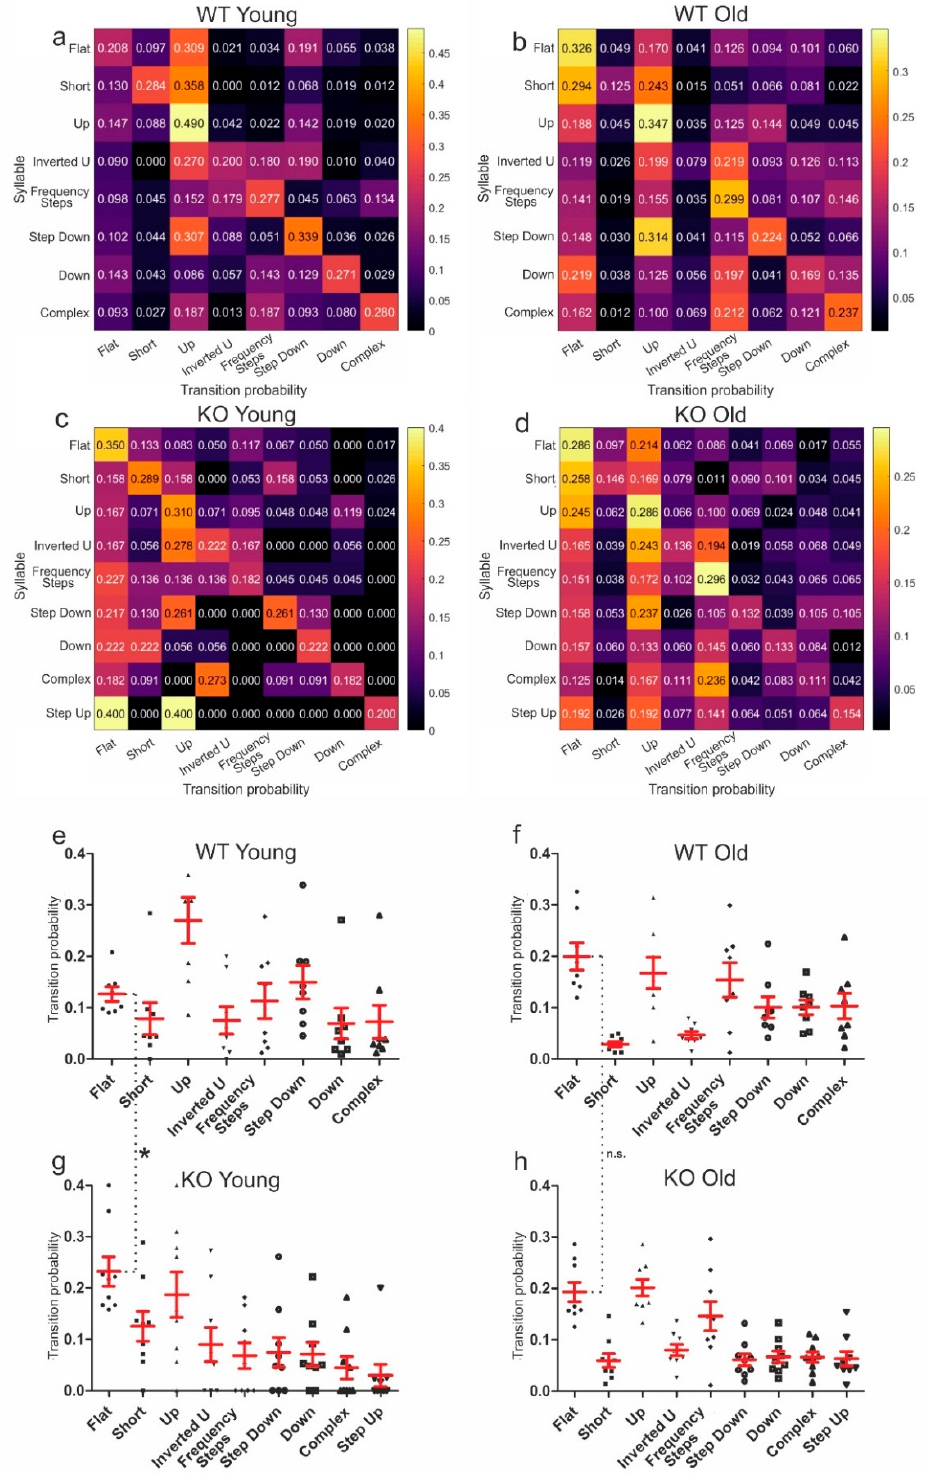
Figure 3. Syntax analysis of transition probabilities, indicating the relative transition prevalence of a certain call following a previous one. ( a – d ) The following call is indicated on the x -axis. ( a ) Transition probabilities of young WT mice. ( b ) Transition probabilities of old WT mice. ( c ) Transition probabilities of young KO mice. ( d ) Transition probabilities of old KO mice. ( e ) Dot plot of the transition probabilities of each WT young call. ( f ) Dot plot of the transition probabilities of calls emitted by the old WT mice. ( g ) Dot plot of the transition probabilities of each KO young call (* p = 0.0061). ( h ) Dot plot of the transition probabilities of calls emitted by the old KO mice.